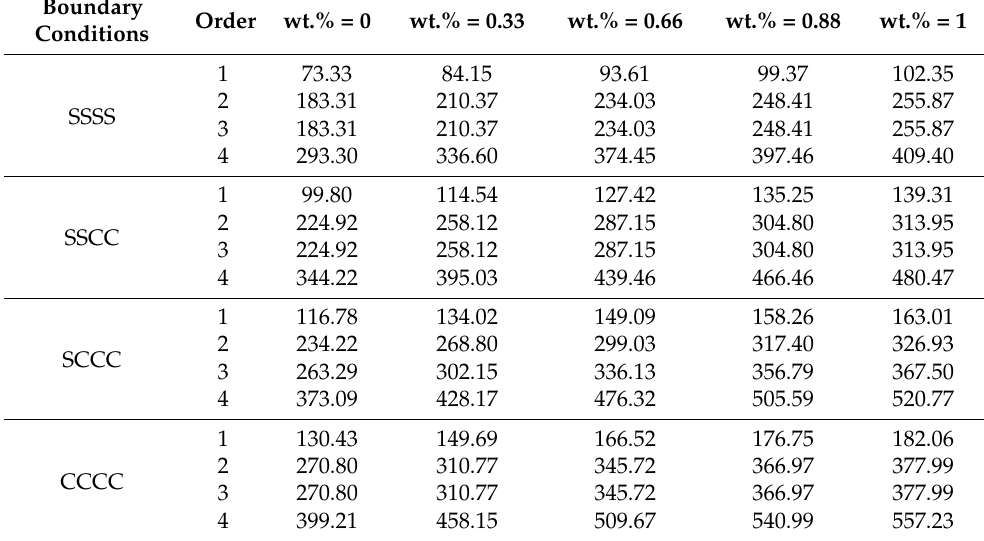
Table A2. Free vibration frequency ω (rad/s) of GPL reinforced porous composite plate with